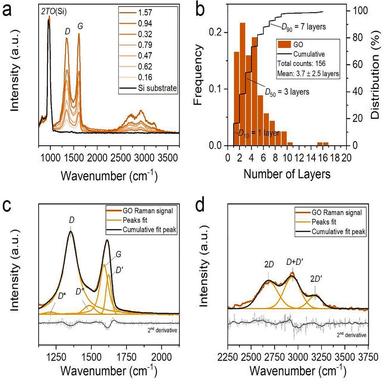
GO (a) representative Raman spectra with different, (b) distribution of the number of layers determined using the Raman-based method and representative deconvoluted Raman spectrum in the region of the (c) - and (d) bands.